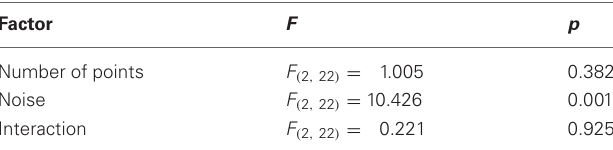
Table A1 | Outcome of 3 × 3 Repeated Measures ANOVA tests of the effects of flow quality and quantity for the 50, 100, 200 number of points levels across all three noise conditions.